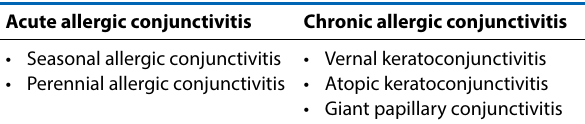
Table 1: The classification of allergic conjunctivitis 1,2,5